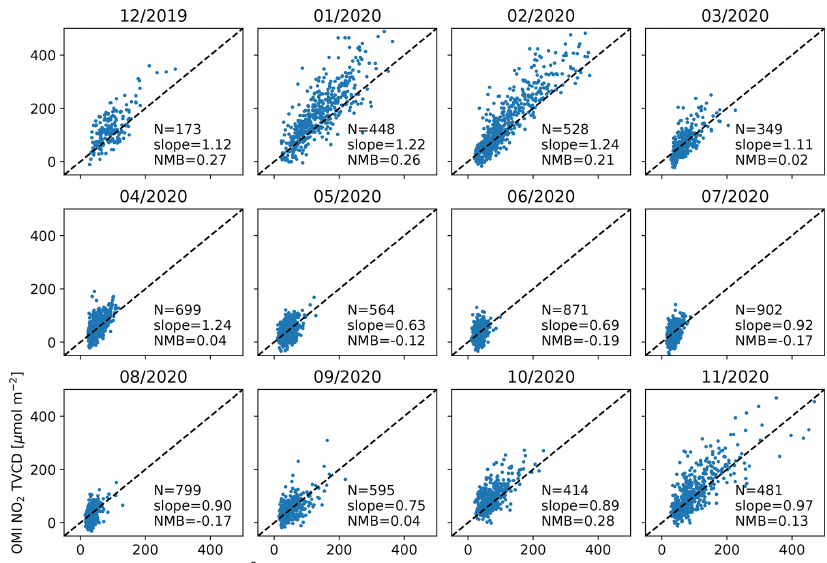
Figure A1. Correlation plots between weight-averaged TROPOMI NO 2 TVCD at OMI pixels and the corresponding OMI NO 2 TVCD; 1 year of data from December 2018 to November 2019 are shown monthly for each panel. The number of collocation pairs ( N ), OMI / TROPOMI slope from OLS regression, and OMI–TROPOMI NMB are shown in each panel. The dashed black line is 1 : 1.